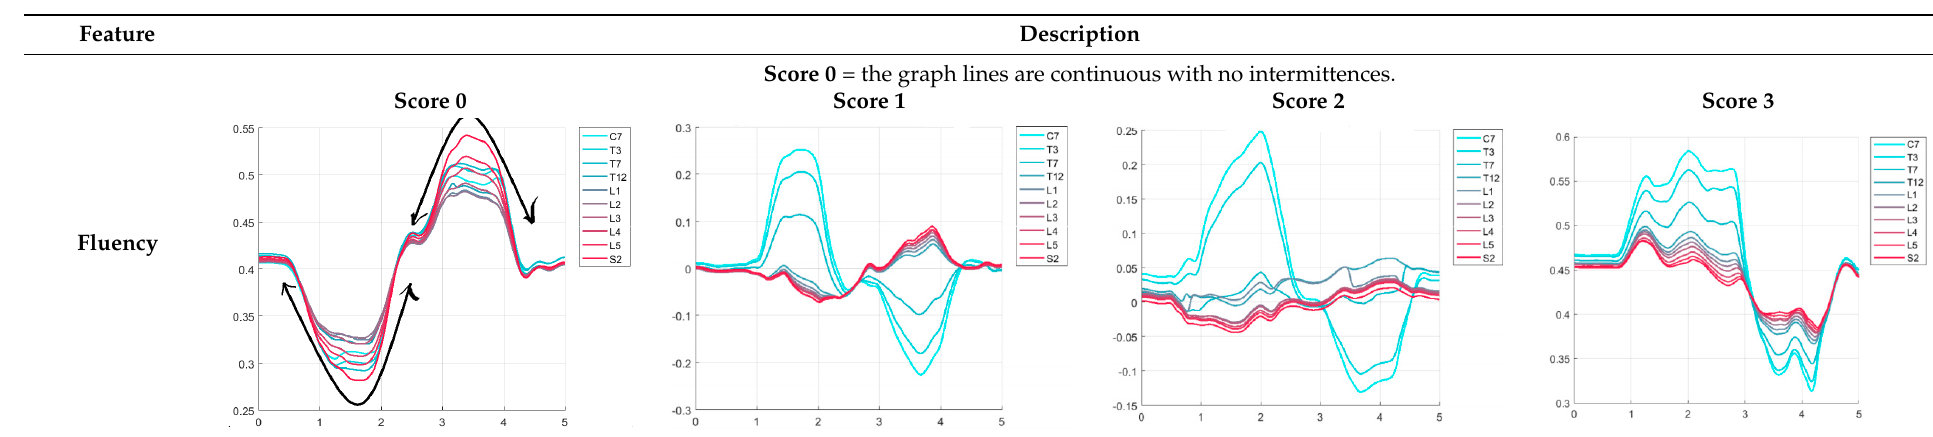
Table A3. Rotation features.